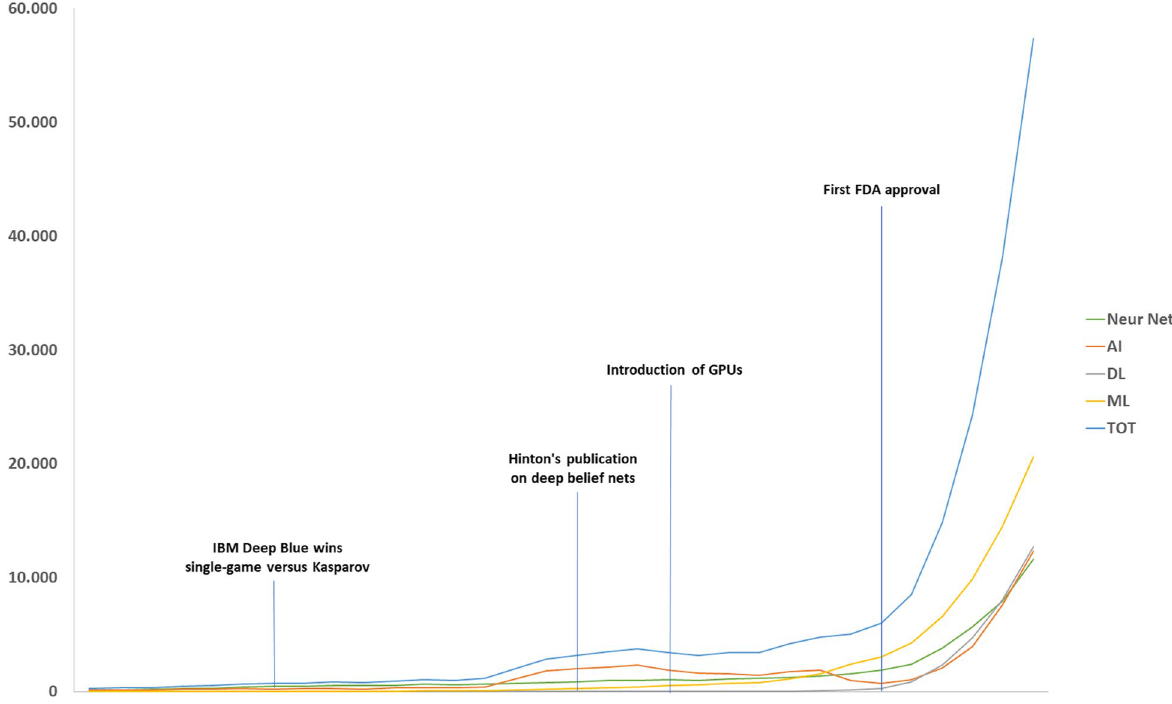
Fig. 1 Number of articles dealing with artificial intelligence, overall and by technique. Four major milestones are shown. Neur Net Neural network, AI Artificial intelligence, DL Deep learning, FDA Food and Drug Administration, GPU Graphics processing units, ML Machine learning, TOT